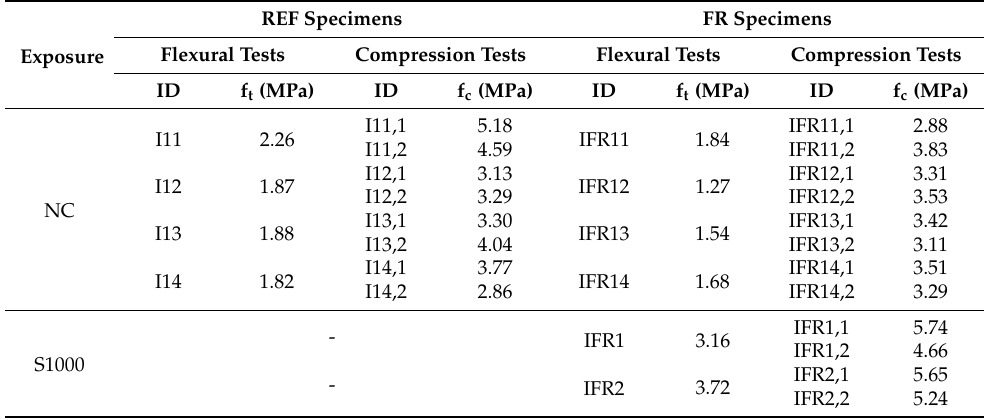
Table A2. Detailed results of flexural and compression tests of specimens of Mixture